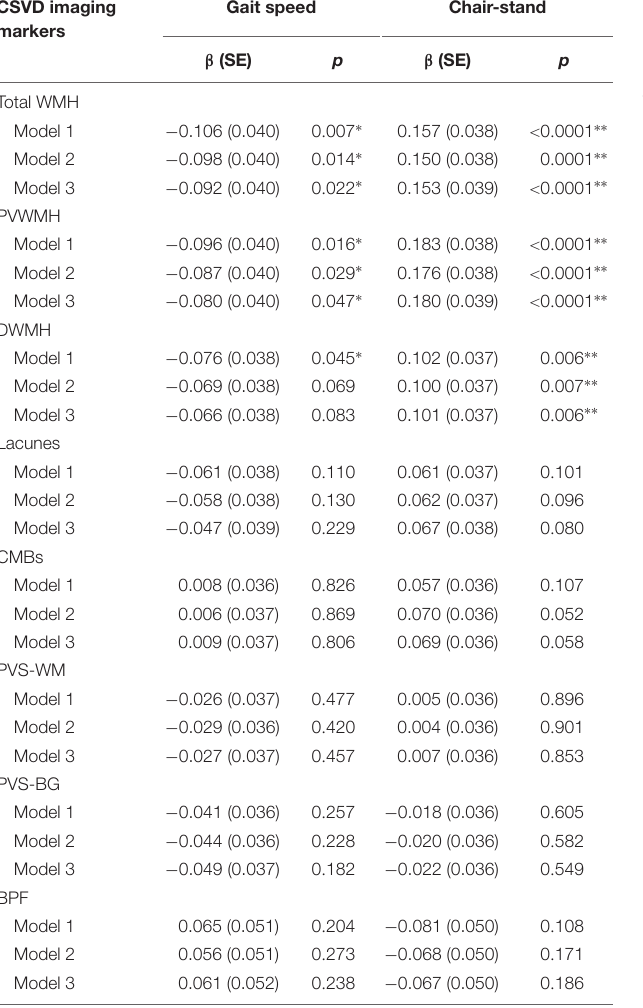
TABLE 2 | Associations between imaging markers of CSVD and motor function of lower extremities. CSVD imaging markers